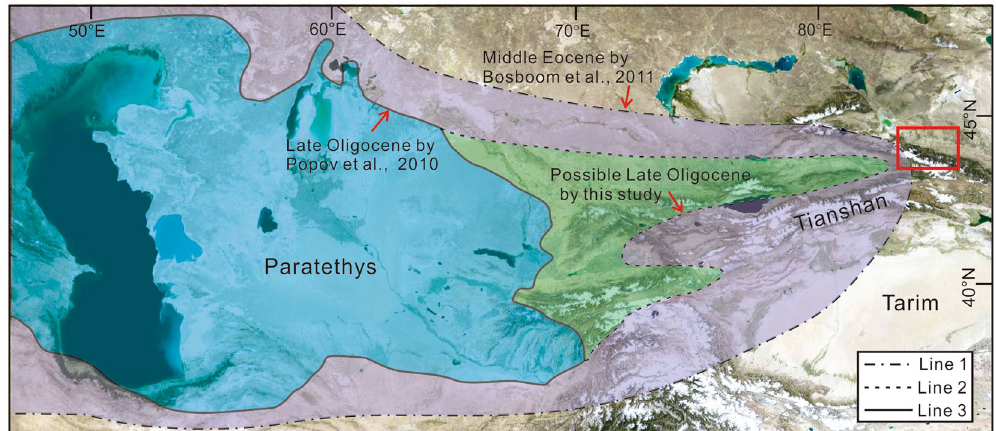
Figure 3. The retreat scheme of the Eastern Paratethys in the central Asian during the Oligocene.The satellite image is from Google Earth (map data: Google, data SIO, NOAA, U.S. Navy, NGA, GEBCO; Image Landsat/ Copernicus). Line 1 indicates the possible distribution of the Paratethys in the Middle Eocene by 6 . Line 2 indicates the possible distribution of the Paratethys in the Late Oligocene by our research. Line 3 indicates the possible Paratethys in the Late Oligocene by 13 . The red box indicates the location of the northern Tianshan Mountains and southern part of the Junggar